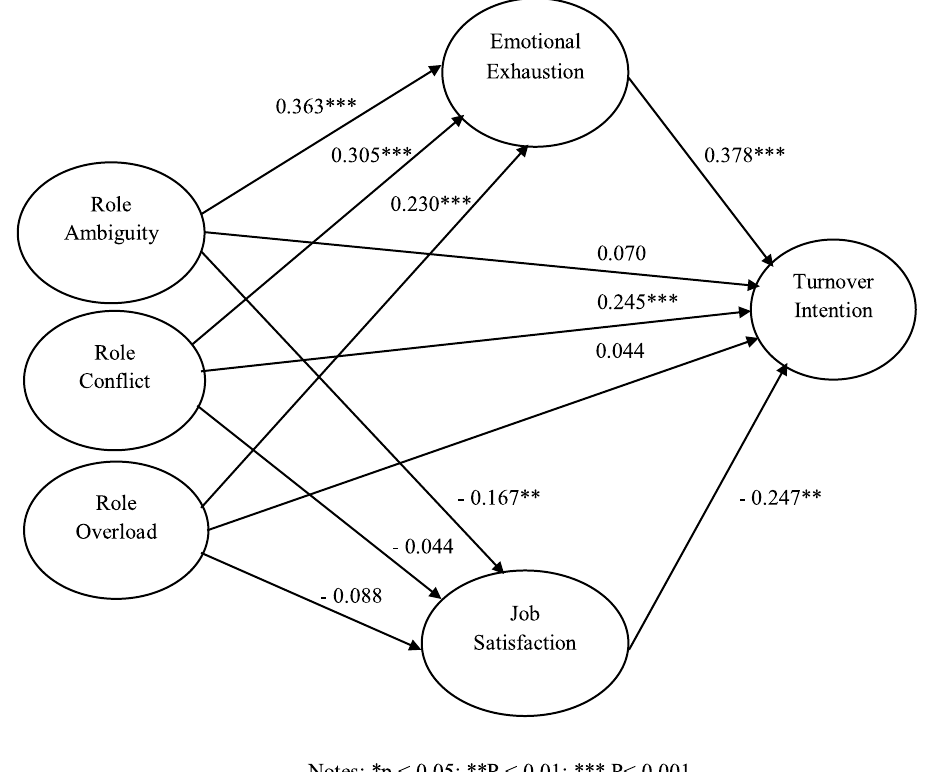
Figure 2. Structural model with standardized path coefficients.